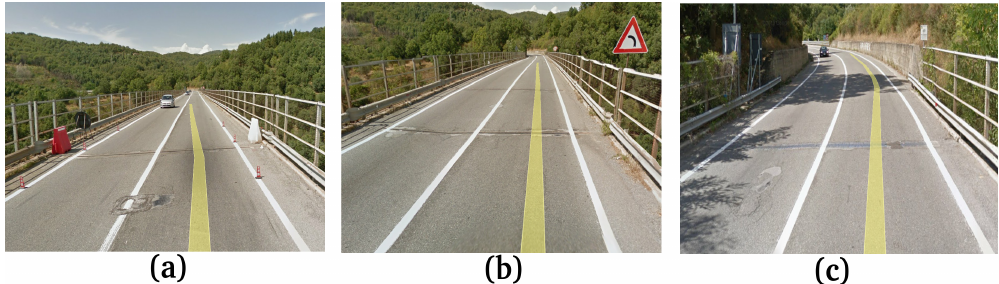
Figure 13. Optical representation of dilatation joints: ( a ) Joint number 4, ( b ) Joint number 5, ( c ) Joint number